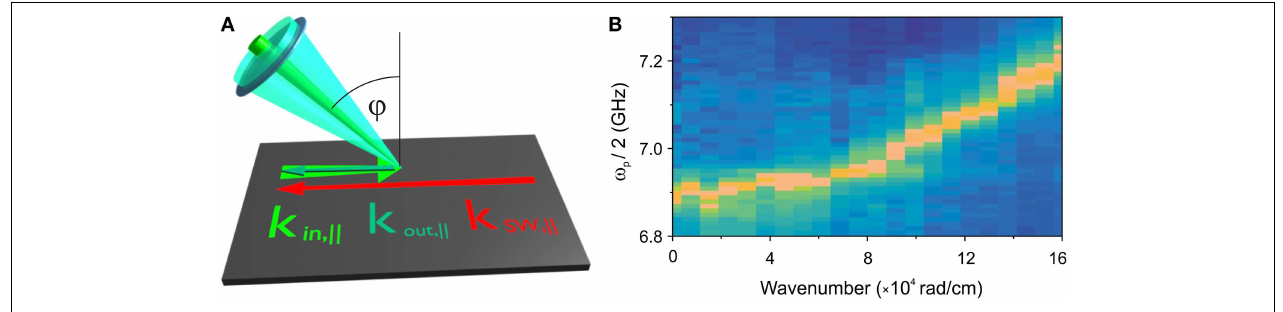
FIGURE 4 | (A) Scheme of the backscattering geometry. By changing the angle of incidence ϕ , the in-plane component of the spin-wave wave vector k sw, k can be determined. (B) BLS measurement of the spin-wave intensity as a function of the spin-wave wave vector of